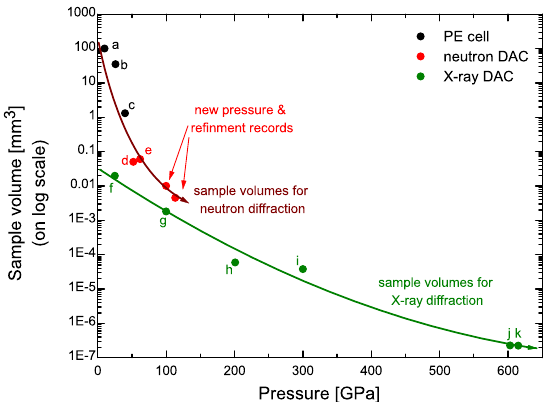
Figure 5. Sample volumes versus maximum pressure achieved during high pressure neutron and X-ray powder diffraction developments. For X-ray powder diffraction developments only DACs using gaskets are added here, for neutron powder diffraction developments, PE cells and neutron DACs (which are both using gaskets) are given. Lines indicating the volume reduction and increasing pressure records are added to guide the eye. Sample volumes during in situ high pressure powder diffraction development are taken from the literature as indicated by lower case letters: ( a ) first 10 GPa refined neutron powder data in a PE cell obtained in 1992 45 ; ( b ) first PE cell pressure data at 26 GPa obtained in 1995 13 ; ( c ) record 40 GPa pressure in the PE cell achieved in 2019 14 ; ( d , e ) refined data obtained in a neutron DAC at 52 GPa and 62 GPa achieved in 2013 and 2019, respectively 28,29 ; ( f ) the first in situ energy-dispersive X-ray powder diffraction performed up to 25 GPa in 1977 42 ; ( g ) the first in situ X-ray diffraction measurements at 1 Mbar in 1978 1 ; ( h , i ) very early 2 Mbar and 3 Mbar in situ X-ray diffraction performed in 1988 43 and 1990 44 ; and ( j , k ) representing the latest 6 Mbar and 6.15 Mbar records achieved in 2018 11,12 ,